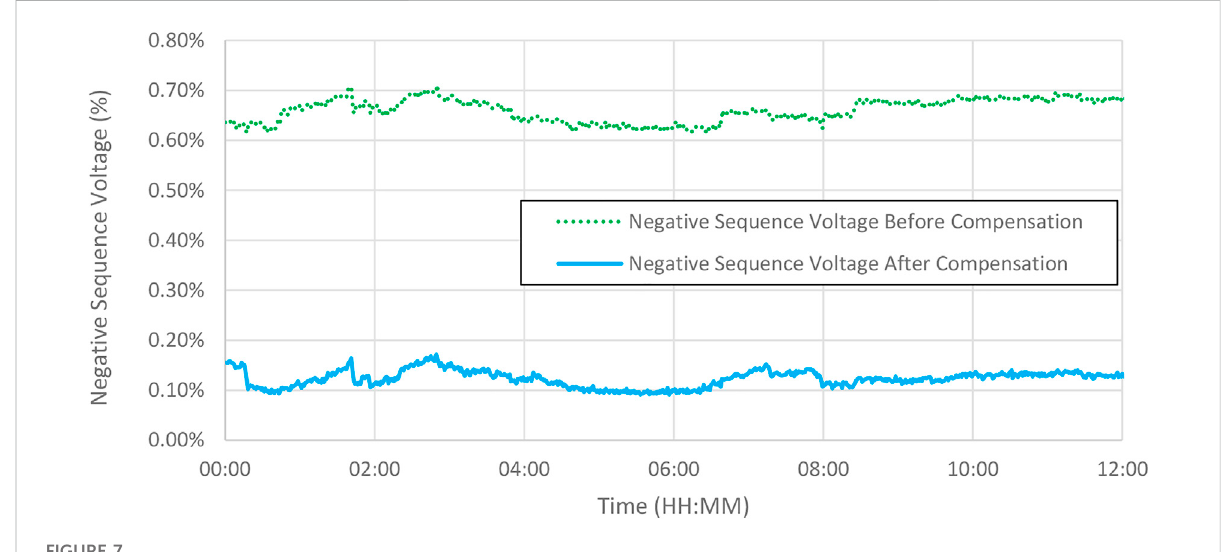
FIGURE 7 Negative-sequence voltage before and after